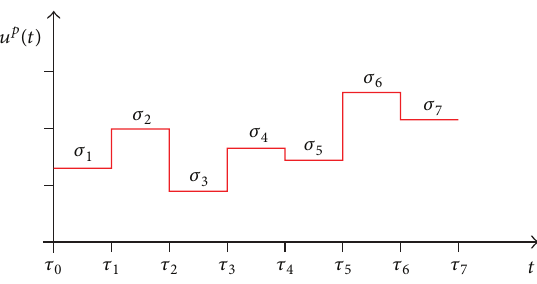
Figure 7: Piecewise-constant control approximation with equidis- tant knot